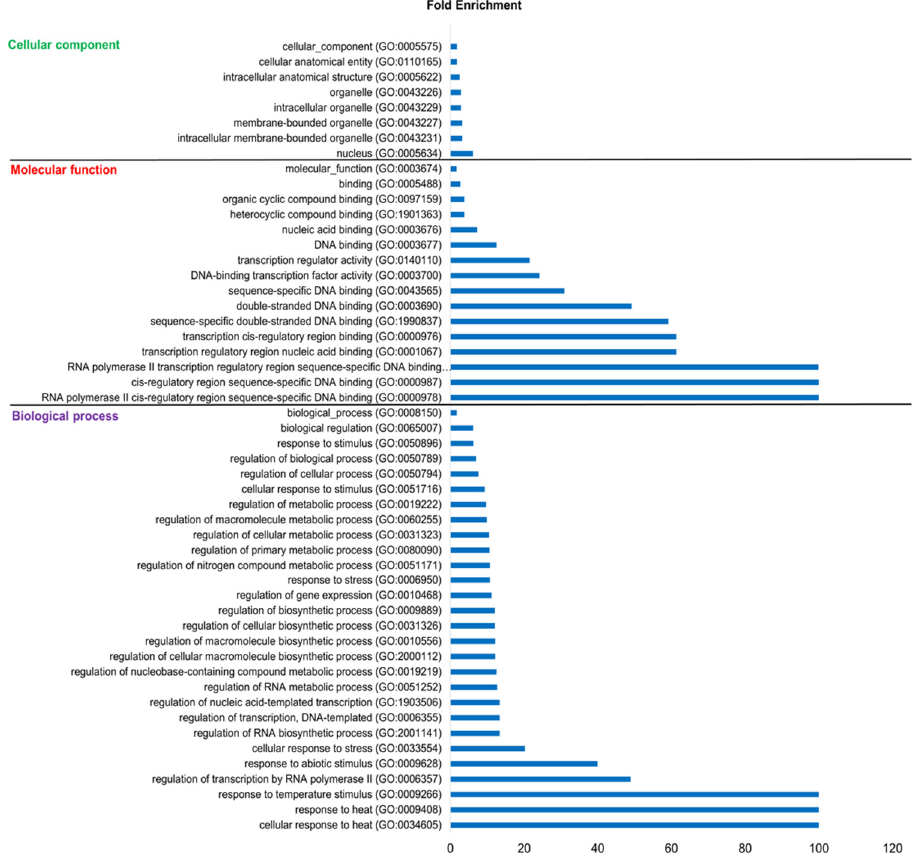
Figure 11. Gene ontology enrichment analysis. The figure depicts the predicted role of HSFs in bio- logical processes, molecular functions, and cellular